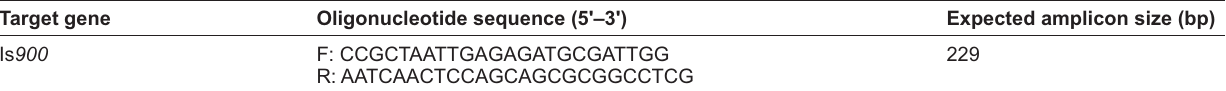
Table-2: Nucleotide sequences of PCR primers (Metabion, Germany). PCR analysis of IS sequence was used to identify the developed culture